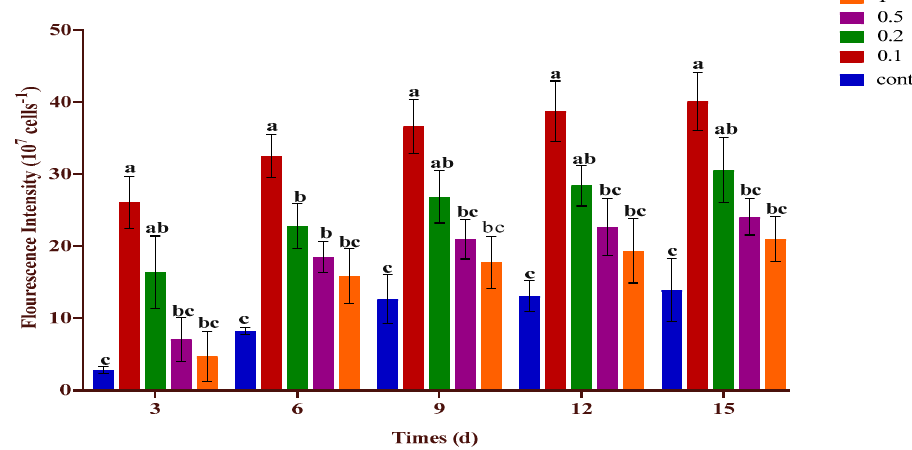
Figure 4. Nile red fluorescence intensity of C. sorokiniana (expressed as 10 7 cells mL − 1 ) under different concentrations of urea combined with KWE. The bar charts represent the means ± SD of triplicate samples ( n = 3). Different alphabets letters indicate significant differences ( p < 0.05) between the urea concentrations.